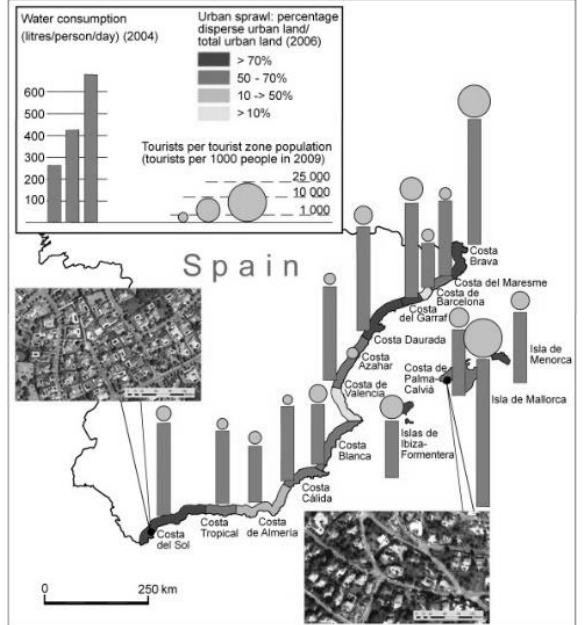
Figure 23. Water consumption in Mediterranean Spanish littoral region.